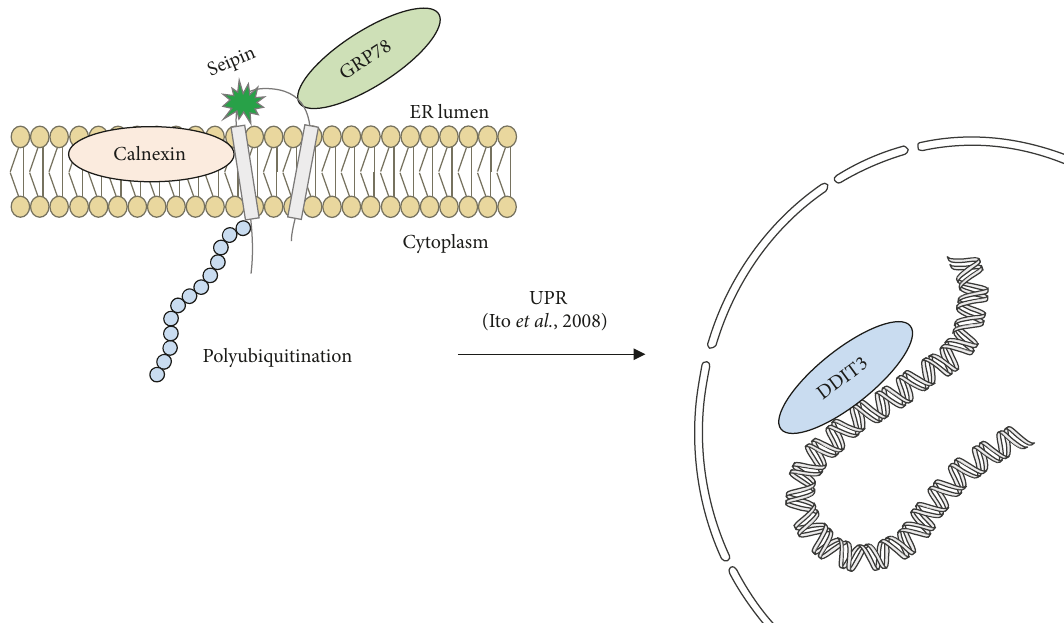
Figure 6: Gain-of-function mutations in seipin elicit ER stress in seipinopathies. Ito et al . proposed a model in which N88S and S90L mutations are able to disturb the seipin glycosylation site and generate ER stress and the unfolded protein response (UPR) [6]. They observed increased apoptosis as a result of the process. DDIT3 (also called CHOP) is a transcription factor responsible for the positive regulation of proapoptoticgenes inresponse toER stress. Calnexin( CANX )and GRP78 (alsocalled BIP) arechaperonesthatwork in UPR. Aswe reviewed, ER stress is not a phenomenon exclusively related to seipinopathy and might also be important for lipodystrophies. Pieces of the illustrations are from the SMART website